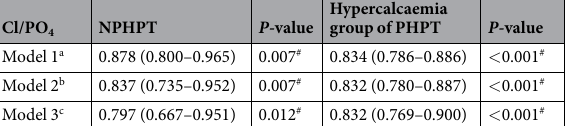
Table 4. Multivariate adjusted ORs (95% CI) of Cl/PO 4 between PHPT and normal controls. a Model 1 was unadjusted. b Model 2 adjusted for age, sex, and BMI. c Model 3 adjusted for the covariate in model 2 plus sodium and Hb. # P < 0.05.